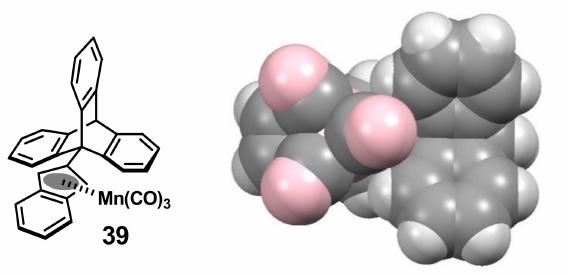
Figure 4. Schematic of a molecular gearing system in which free rotation of the paddlewheel P is controlled by sliding the “latch” Y of the shuttle Figure 17. Space-fill view of [ η 5 -2-(9-triptycyl)indenyl]tricarbonylmanganese, 39 , showing how a carbonyl ligand is positioned directly between two blades of the triptycene.